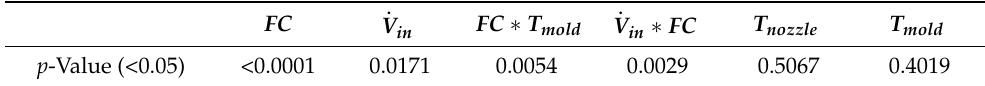
Table 3. p -values of various test parameters for Young ´ s modulus.